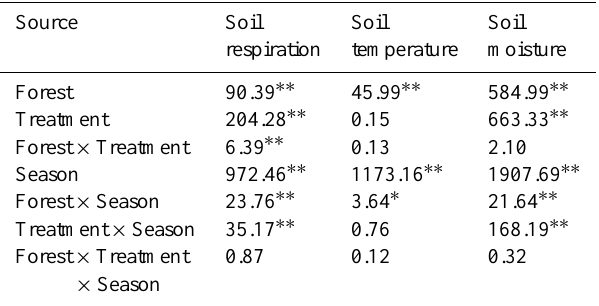
Table 2. Significance of the effects of forest type, precipitation treatment, season and their interactions on soil respiration rate, soil temperature, and soil moisture, respectively, at the Dinghushan Na- ture Reserve, China. Numbers are F values. Stars indicate the level of significance ( ∗ = P < 0 . 05, ∗∗ = P < 0 .